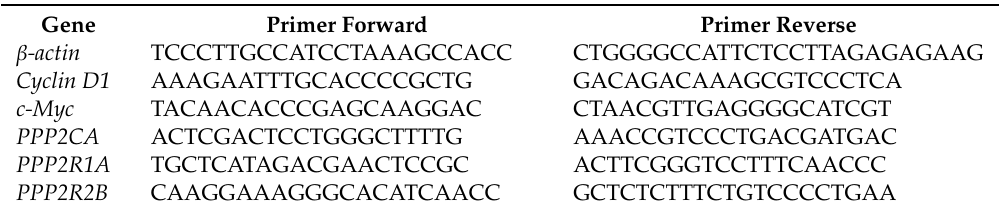
Table 1. Sequences of qRT-PCR